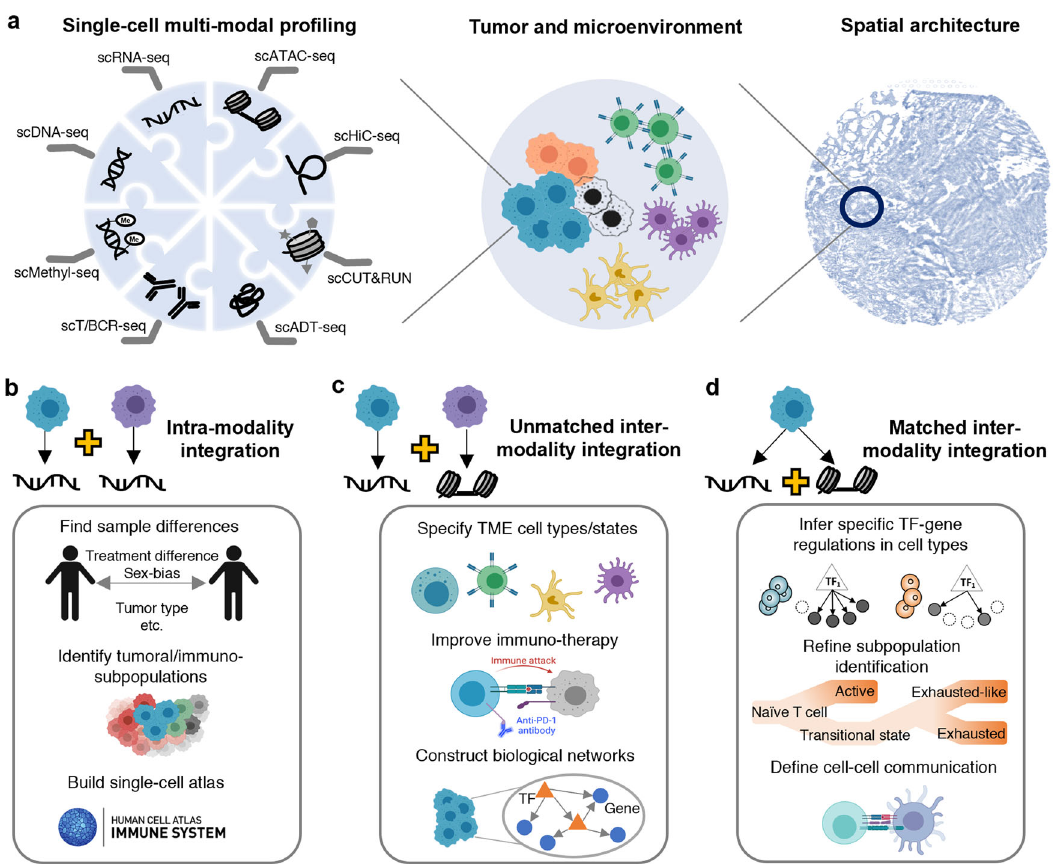
Fig. 1 scMulti-omics pro fi ling and application examples in immuno-oncology. a An overview of various scMulti-omics data types. Sequencing techniques including single-cell DNA sequencing (scDNA-seq) for DNA sequence pro fi ling, single-cell RNA sequencing (scRNA-seq) for gene expression pro fi ling, Single-cell sequencing assay for transposase-accessible chromatin sequencing (scATAC-seq) for chromatin accessibility pro fi ling, single-cell high- throughput chromosome conformation sequencing (scHiC-seq) for chromatin architecture organization, single-cell cleavage under targets and release using nuclease (scCUN&RUN) for histone modi fi cation pro fi ling, single-cell antibody-derived tag sequencing (scADT-seq) for protein abundance pro fi ling, single-cell T cell or B cell receptor sequencing (scT/BCR-seq) for receptor repertoire (the recombination of the variable (V), diversity (D), and joining (J) genes of T/B cell receptors) diversity and clonality pro fi ling, and single-cell methylation sequencing (scMethyl-seq) for DNA methylation status pro fi